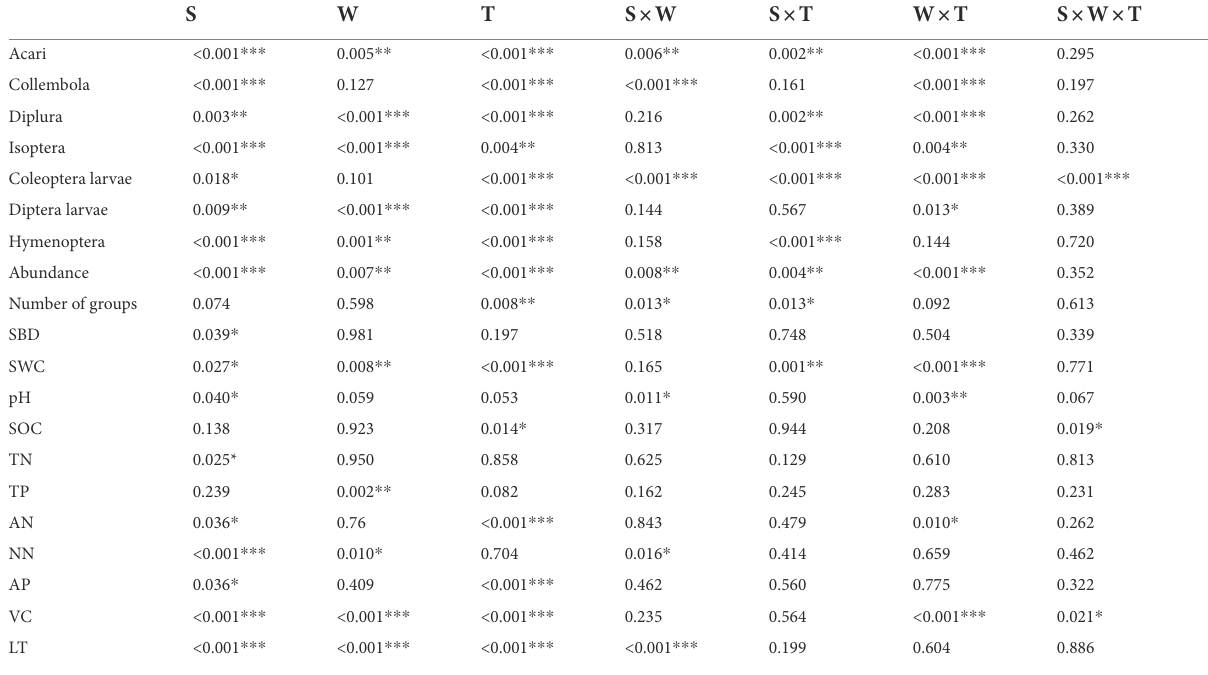
TABLE 2 ANOVA results for environmental factors and main groups as affected by habitat types (S), wildfire (W), sampling time (T) and their interactions (S × W, S × T, W × T, S × W × T).